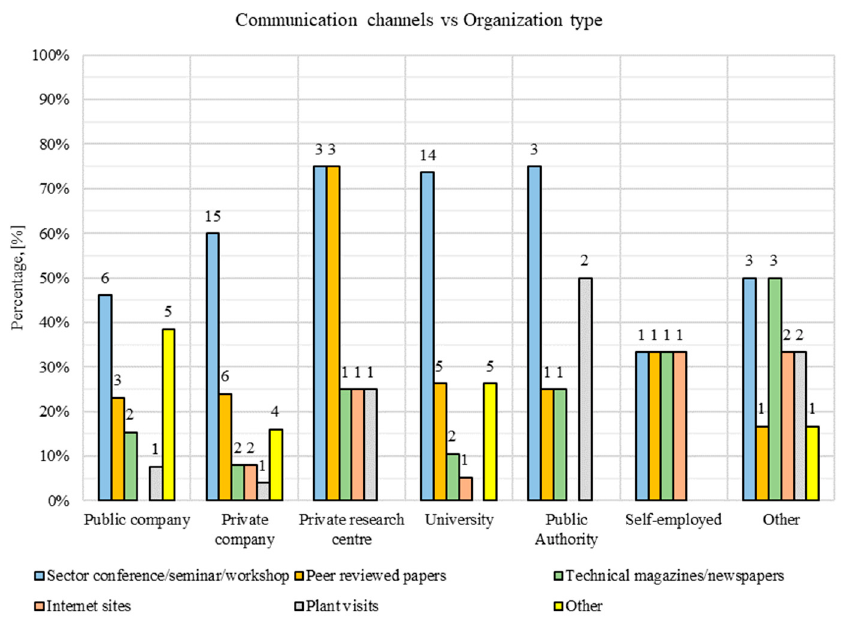
Figure 11. Communication channels as a function of the organization type.